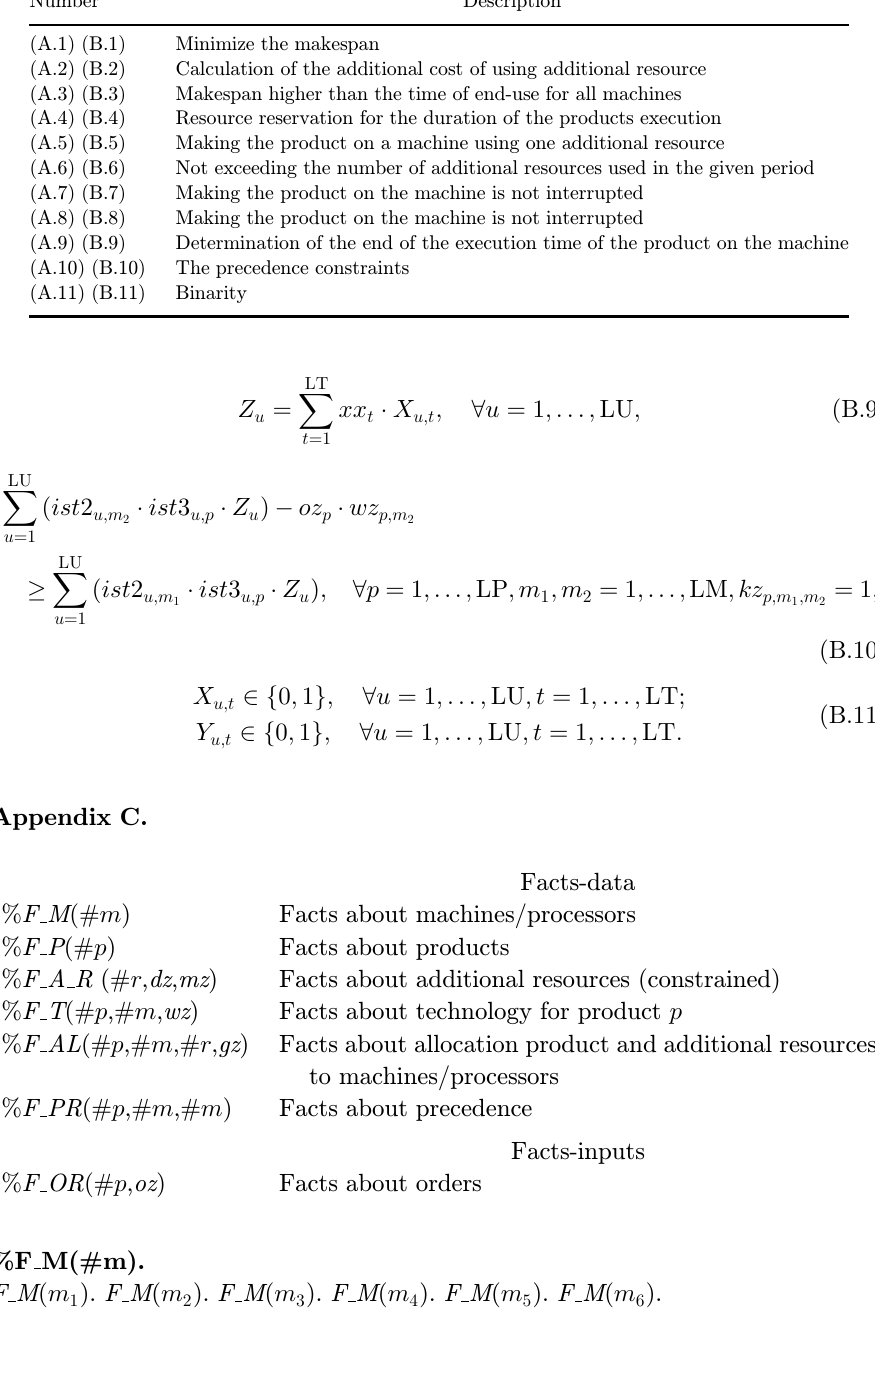
Table B.2. Description of the constraints for both models. Number Description (A.1)